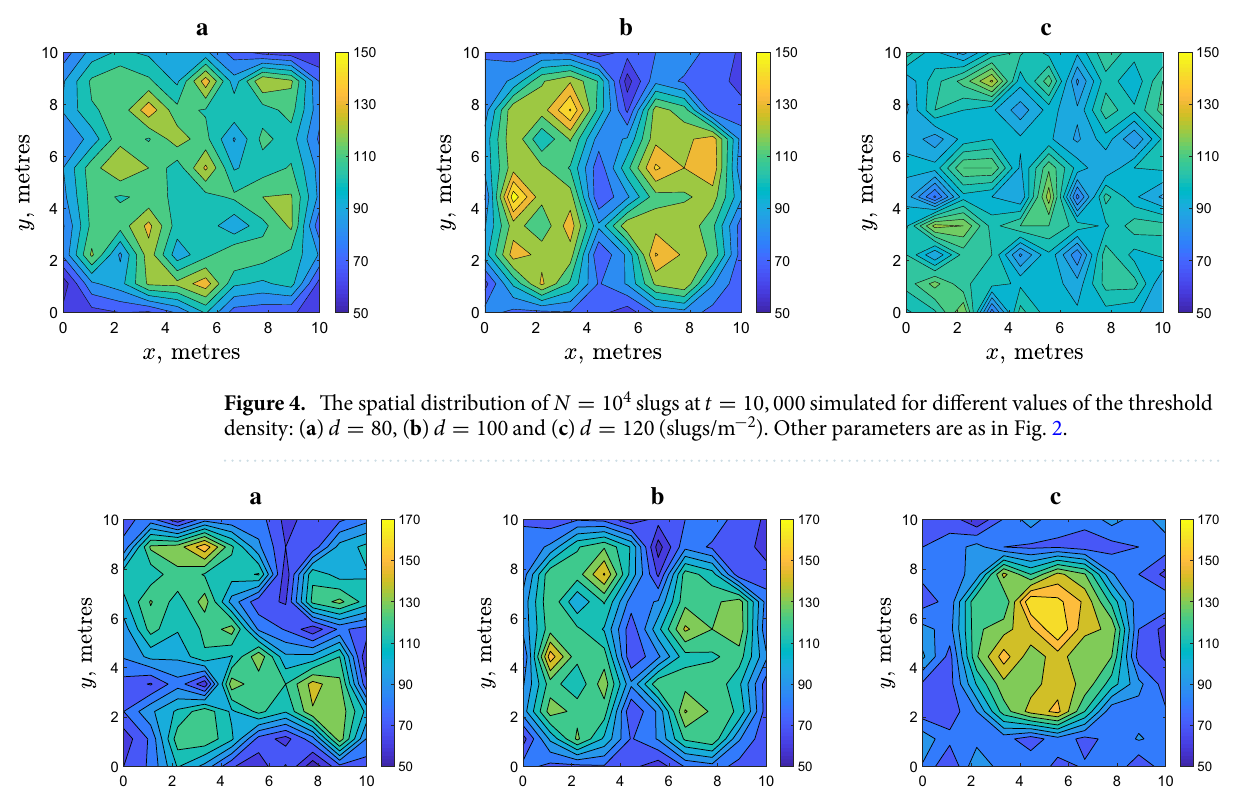
10 4 slugs at t 10 4 simulated for different values of the perception Figure 5. The spatial distribution of N = = 0.5 , ( b ) R 3 . Other parameters are as in Fig. 1 and ( c ) R radius: ( a ) R = = =